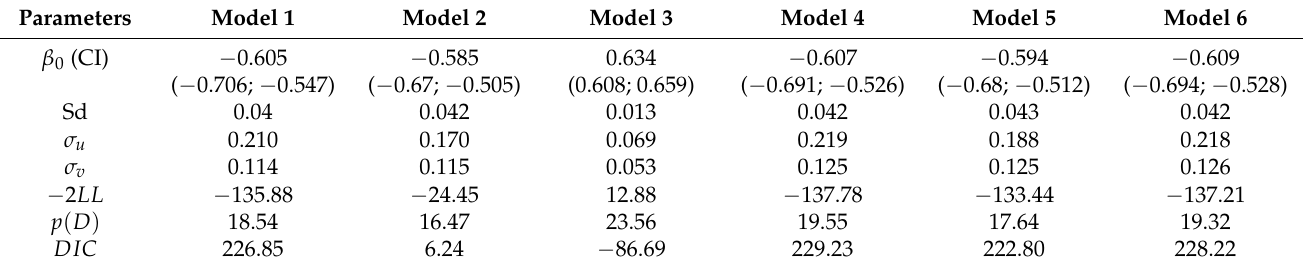
Table 1. A comparison of spatial models for mapping child stunting in Malawi using 2015-16 MDHS.